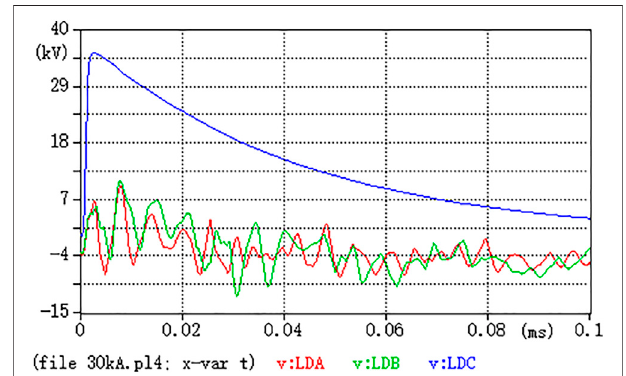
FIGURE 6 | Maximum overvoltage waveform of 10 kA lightning current amplitude invading #1 overhead line near tower.